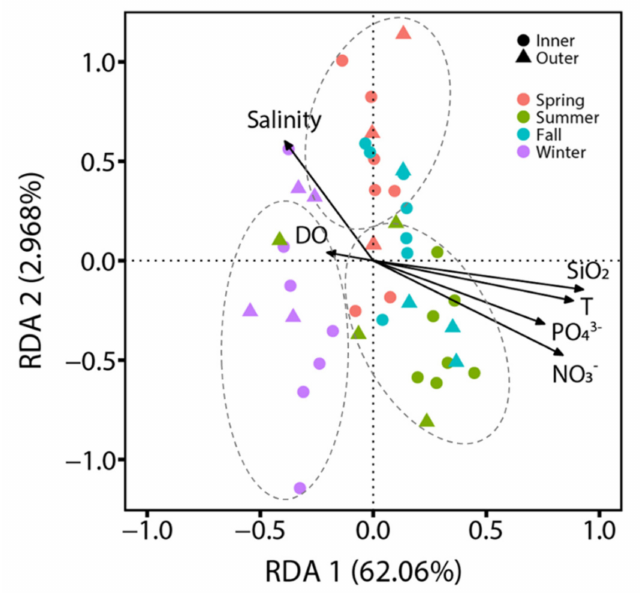
Figure 6. Redundancy analysis (RDA) presenting the relationship between the phytoplankton community and environmental variables during the sampling periods in the inner and outer bays of Gwangyang Bay. Abbreviations are as follows: DO = dissolved oxygen, T =